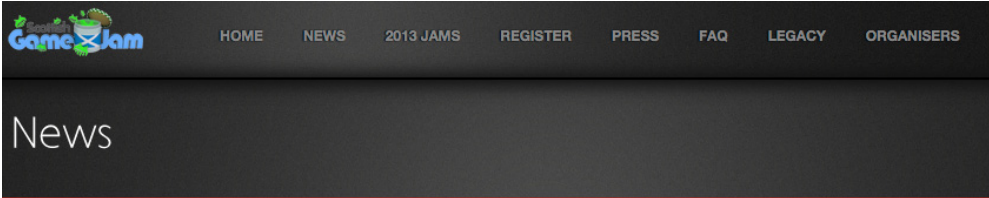
Figure 5. Home page of the Scottish Game Jam,